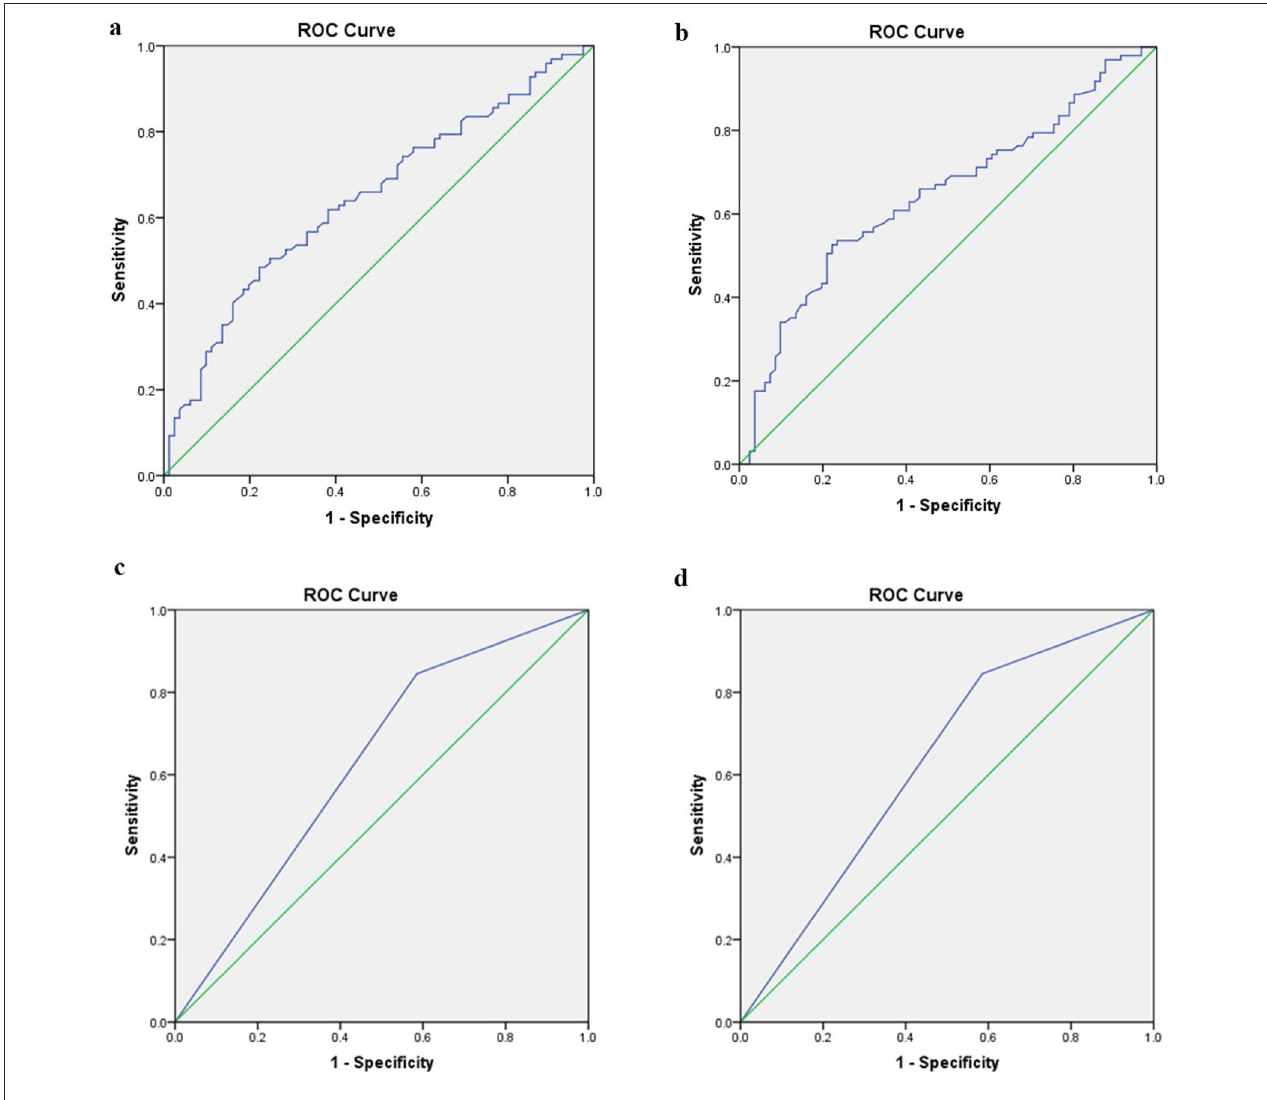
FIGURE 5 | Receiver operating characteristic curves for the two radiological variables that showed significant difference between unilateral MD and VM. (a) Difference of MRI-PP distance between the affected side of MD and left side of VM. (b) Difference of MRI-PP distance between the affected side of MD and right side of VM. (c) Difference of MRI-VA visibility between the affected side of MD and left side of VM. (d) Difference of MRI-VA visibility between the affected side of MD and right side of VM. ROC, receivers operating characteristic; MD, Ménière’s disease; VM, vestibular migraine; PP distance, distance between the vertical part of the posterior semicircular canal and the posterior fossa; VA, vestibular